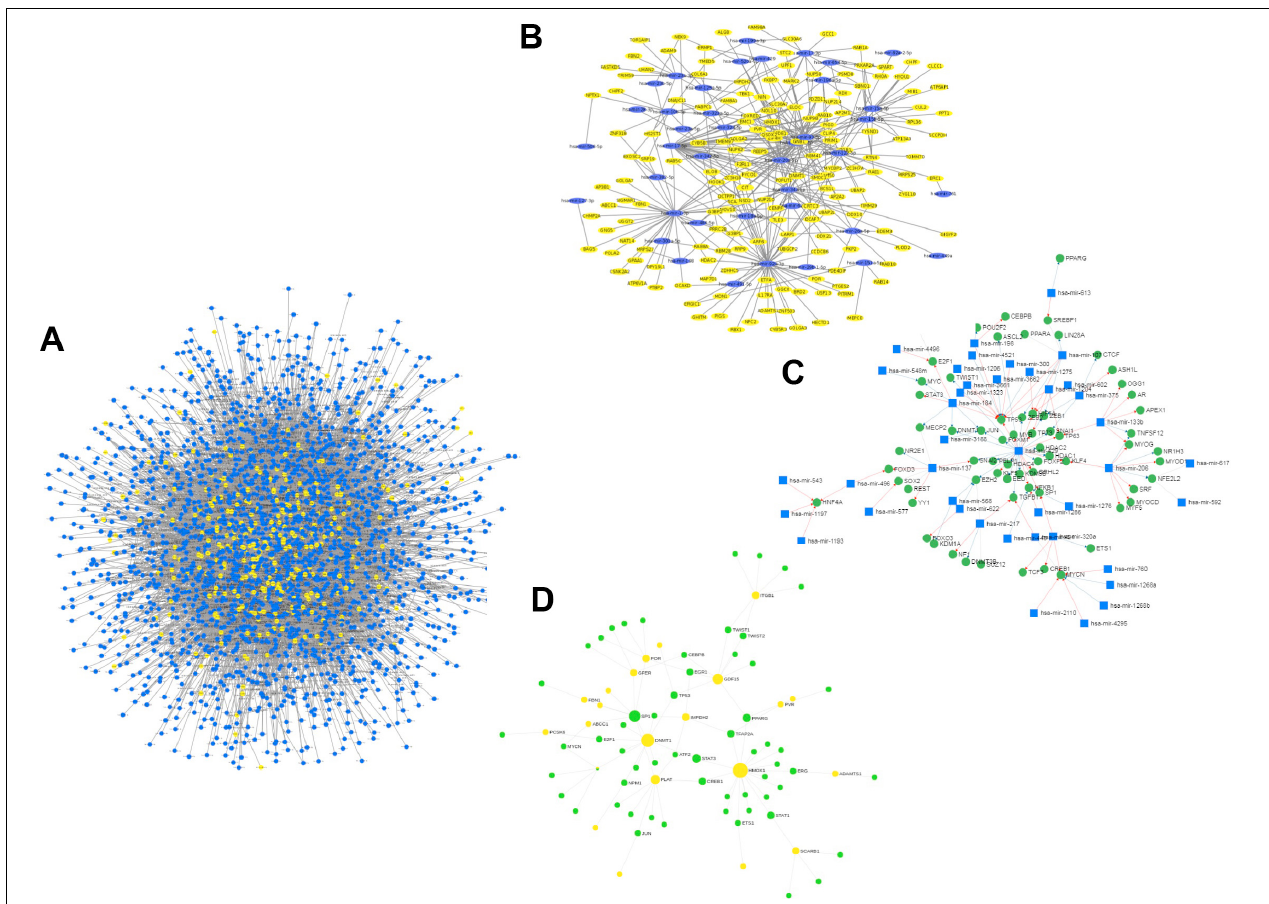
FIGURE 4 | (A) miRNA-target (host genes) interactome. (B) Subnetwork of reported anti-viral miRNA ( n = 38) interaction network. (C) miRNA–TF interactome for host genes (green nodes represent TFs, blue nodes represent miRNAs, and yellow nodes represent target host genes). (D) GRN of TF targeting host genes.